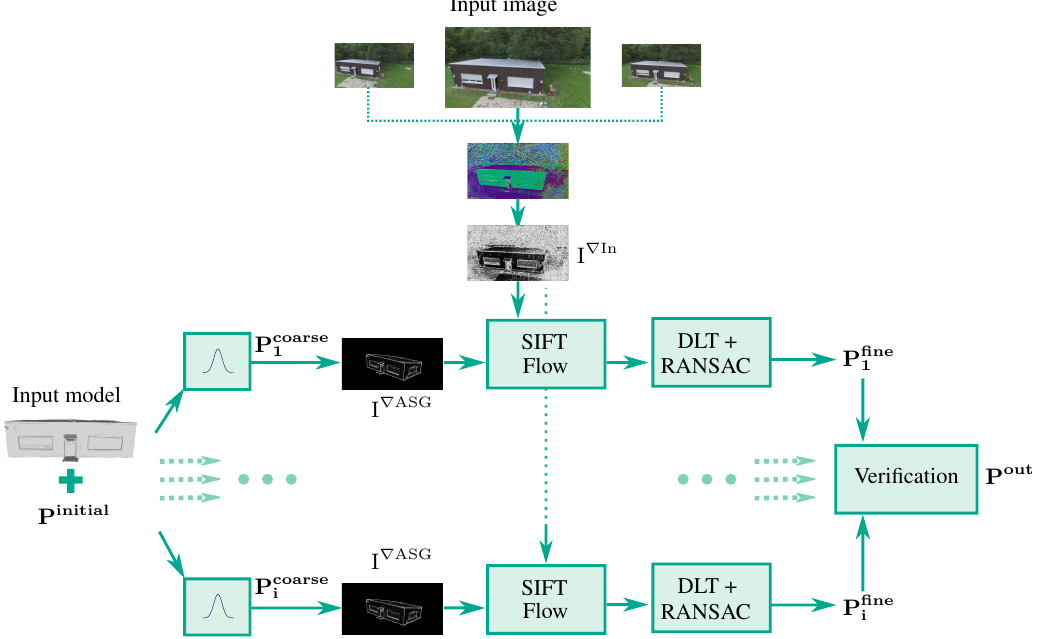
Figure 2. Overview of the processing pipeline of the co-registration algorithm: Gradient images rendered from the model are matched to a gradient image of the photograph using SIFT flow. The correspondences determined are used to estimate the relative pose based on a DLT. The final pose is selected in the verification